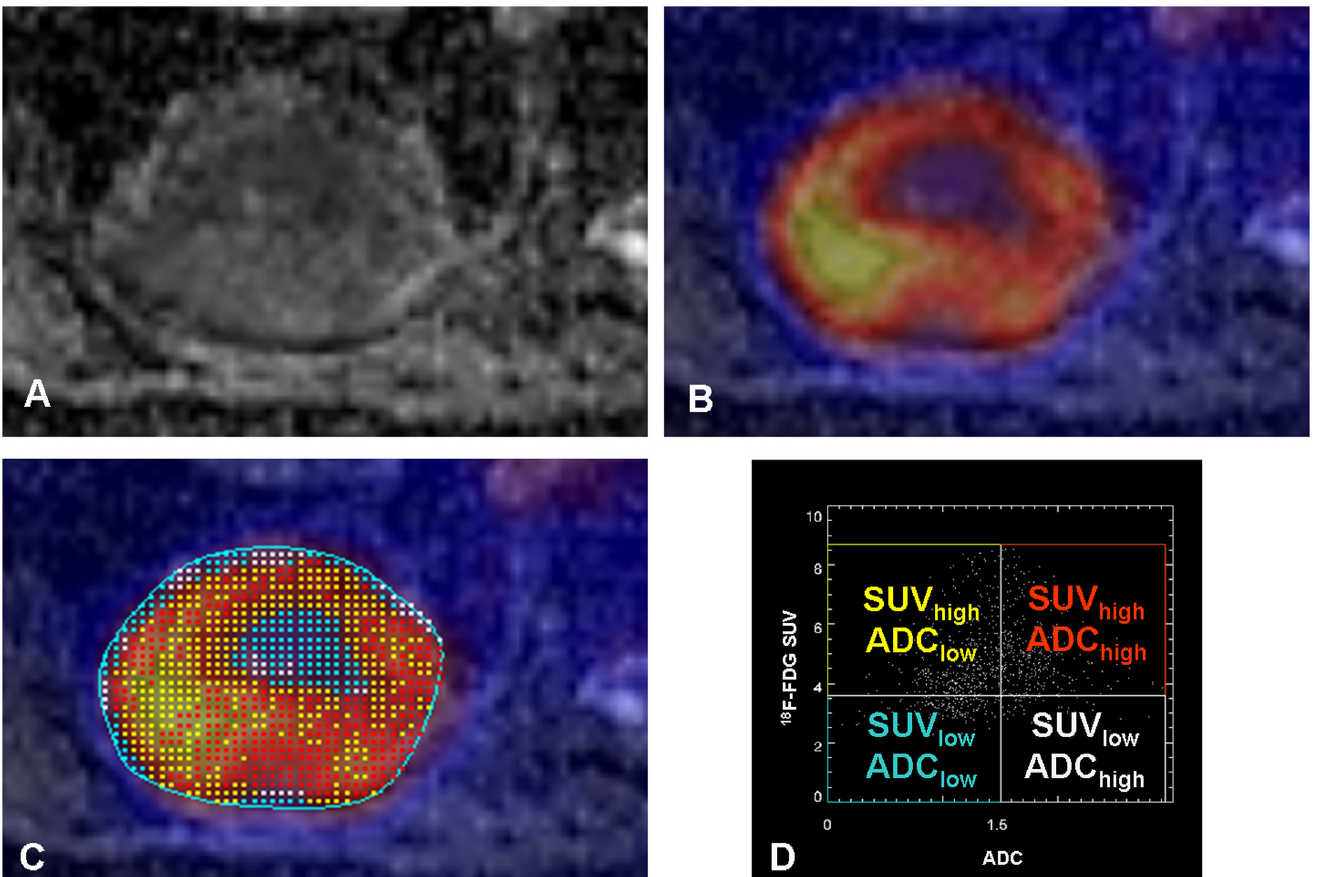
Fig 5. A-D. Patient with a primary NSCLC of the right lower lobe adjacent to the posterior chest wall (A: ADC map from DW-MRI). There is high 18 F-FDG uptake in the periphery of the tumor and also the transition zone, with low uptake in the center (B image fusion of 18 F-FDG PET and the ADC map). A ROI is placed around the tumor (C, blue circle) and the Anima M 3 P software then displays a scatter plot of the voxels within the ROI (D). Thresholds for low and high tracer uptake (y-axis) and low and high ADC values (x-axis) were defined (SUV = 3.6 for 18 F-FDG and ADC 1.5 x10 -3 mm²/s) and the localization of the voxels of each quadrant (yellow: SUV high /ADC low ; red: SUV high /ADC high ; blue: SUV low /ADC low ; gray: SUV low /ADC high ) can be displayed in the fused image (C). The potential biological correlate of each of the four clusters is displayed in (D).